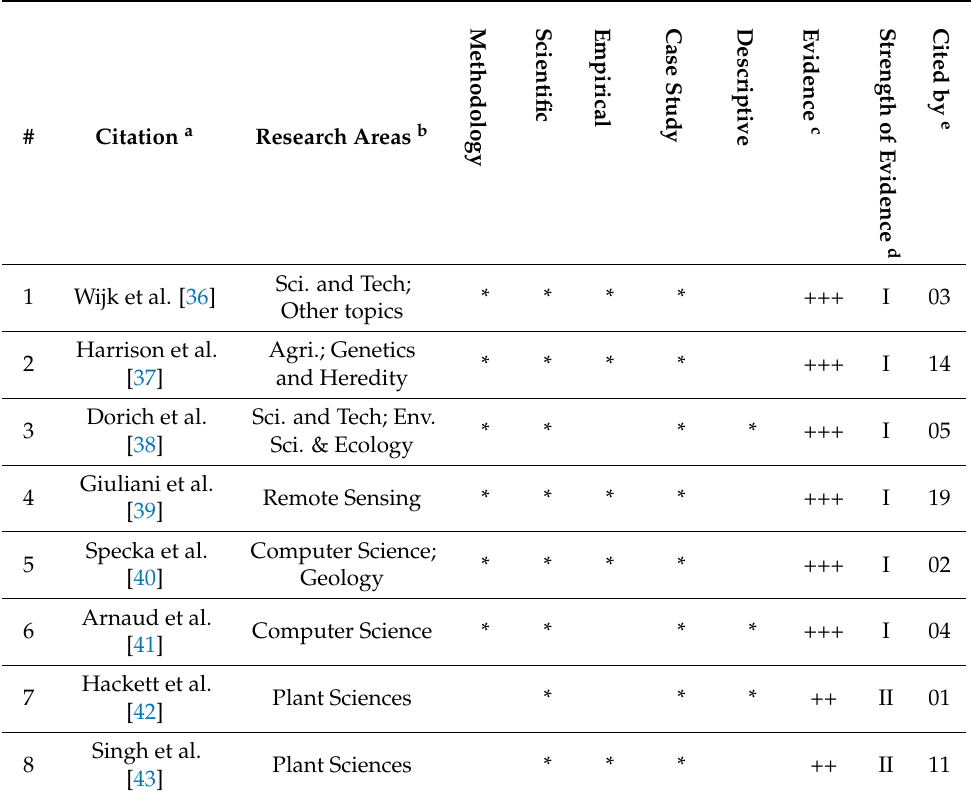
Table 2. Assessment of the selected studies based on their strength of evidence.